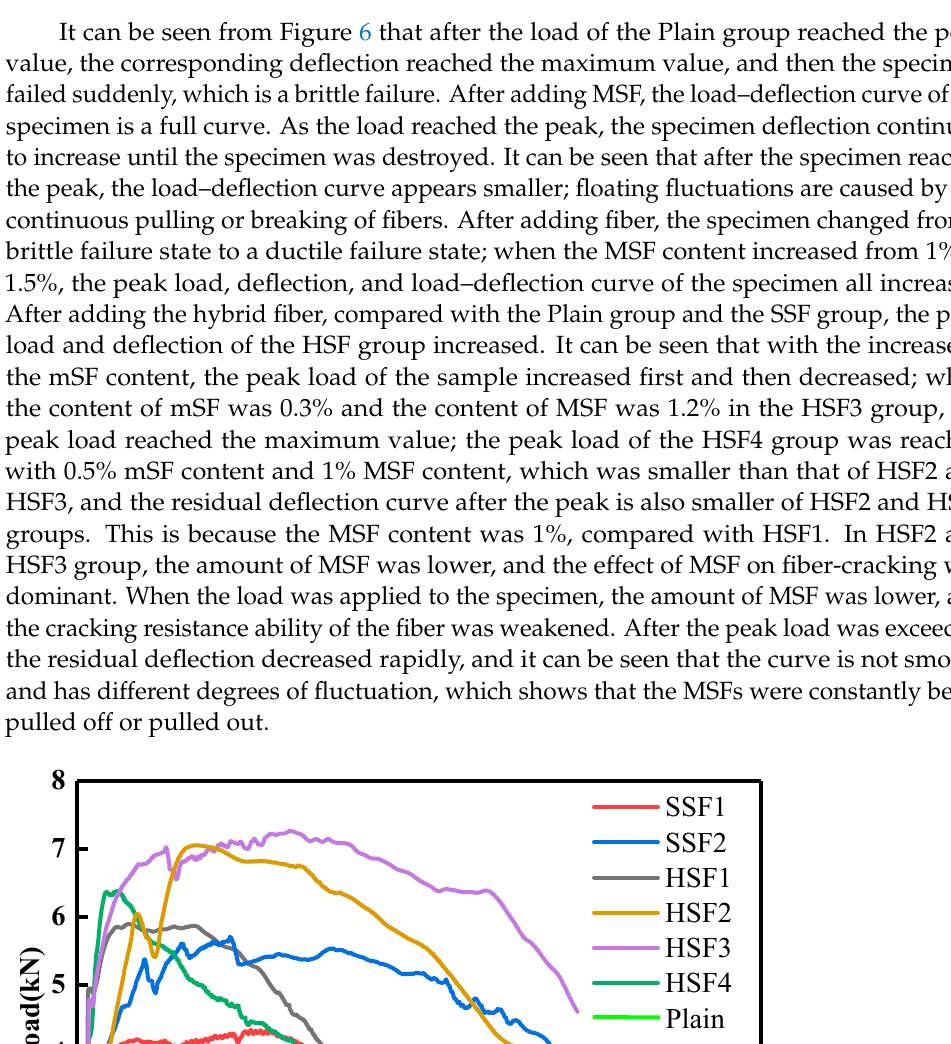
(6) Figure 7 shows the initial crack strength of the specimen. It can be seen that after adding mSF, the initial crack strength of the HSF group is significantly greater than that of the SSF2 group, and the initial crack strengths of SSF1, SSF2, HSF1, HSF2, HSF3, HSF4 are 7.01 MPa, 6.86 MPa, 9.28 MPa, 7.74 MPa, 8.97 MPa, 7.87 MPa, respectively. Compared with the SSF2 group, the initial crack strengths of the HSF1, HSF2, HSF3, and HSF4 groups were increased by 35.3%, 12.8%, 30.8%, and 14.7%, respectively, indicating that the HSF groups have higher loads and deflections. It can be seen that the HSF4 group has the